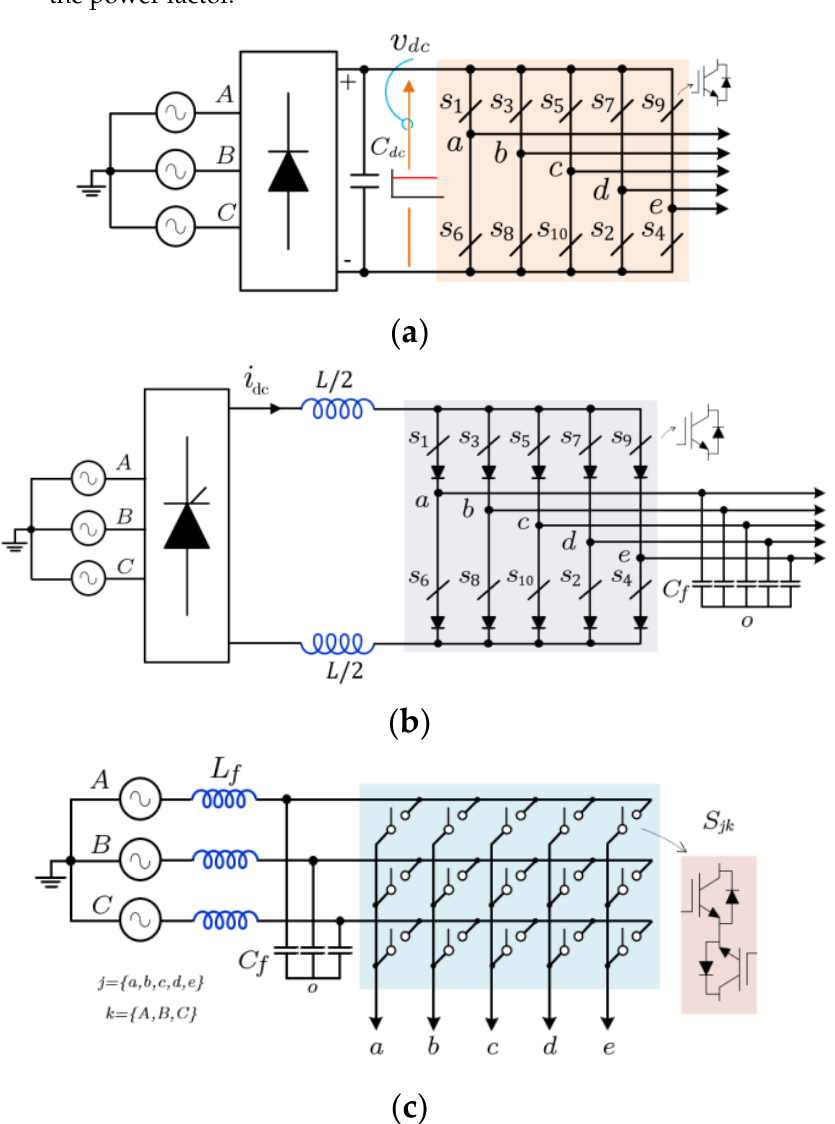
Figure 1. Basic power converters for five-phase drives. ( a ) Five-phase voltage-source inverter (VSI) [4]. ( b ) Five-phase current-source inverter (CSI) [5]. ( c ) Three-phase to five-phase matrix converter (MC) [6].